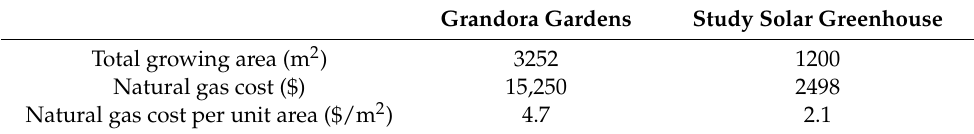
Table 5. Heating cost comparison between Grandora Gardens and the conceptual solar